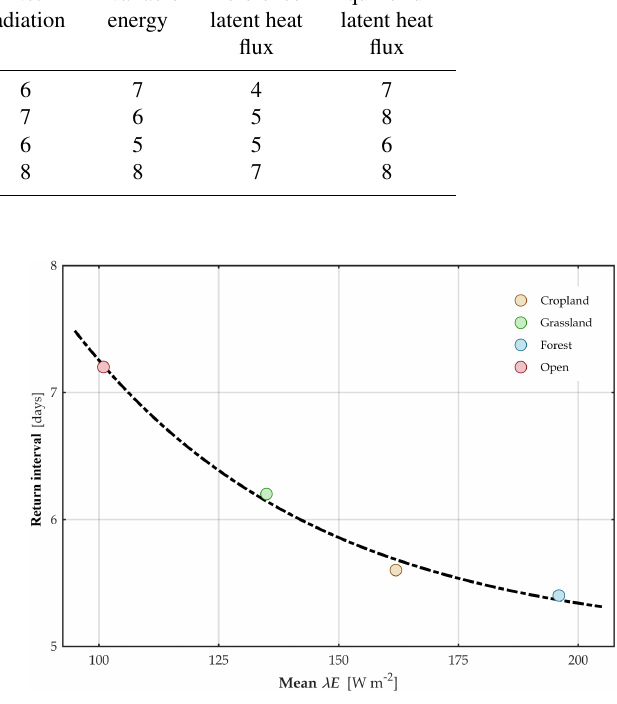
Figure 10. The maximum return interval where the relative error is less than 20% plotted as a function of the mean daytime latent heat